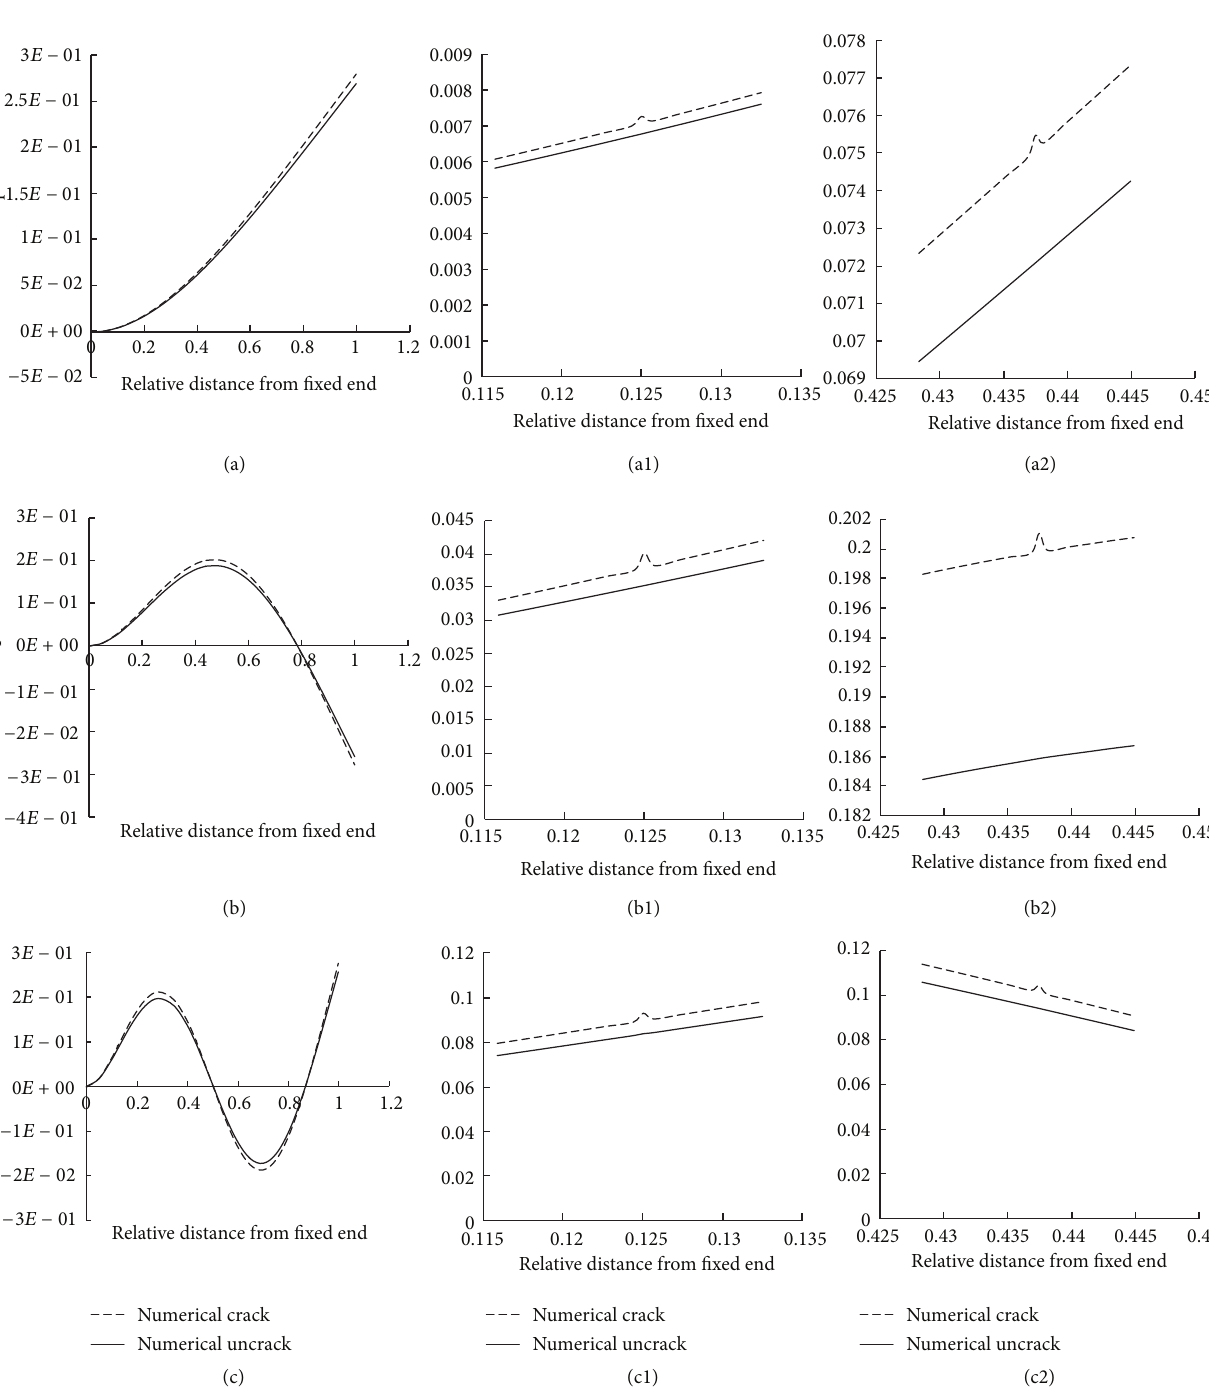
/𝐿 = 0.125 . (a2) Magnified view of (a) at the vicinity of 1 /𝐿 = 0.125 . (b2) Magnified 1 /𝐿 = 0.4375 2